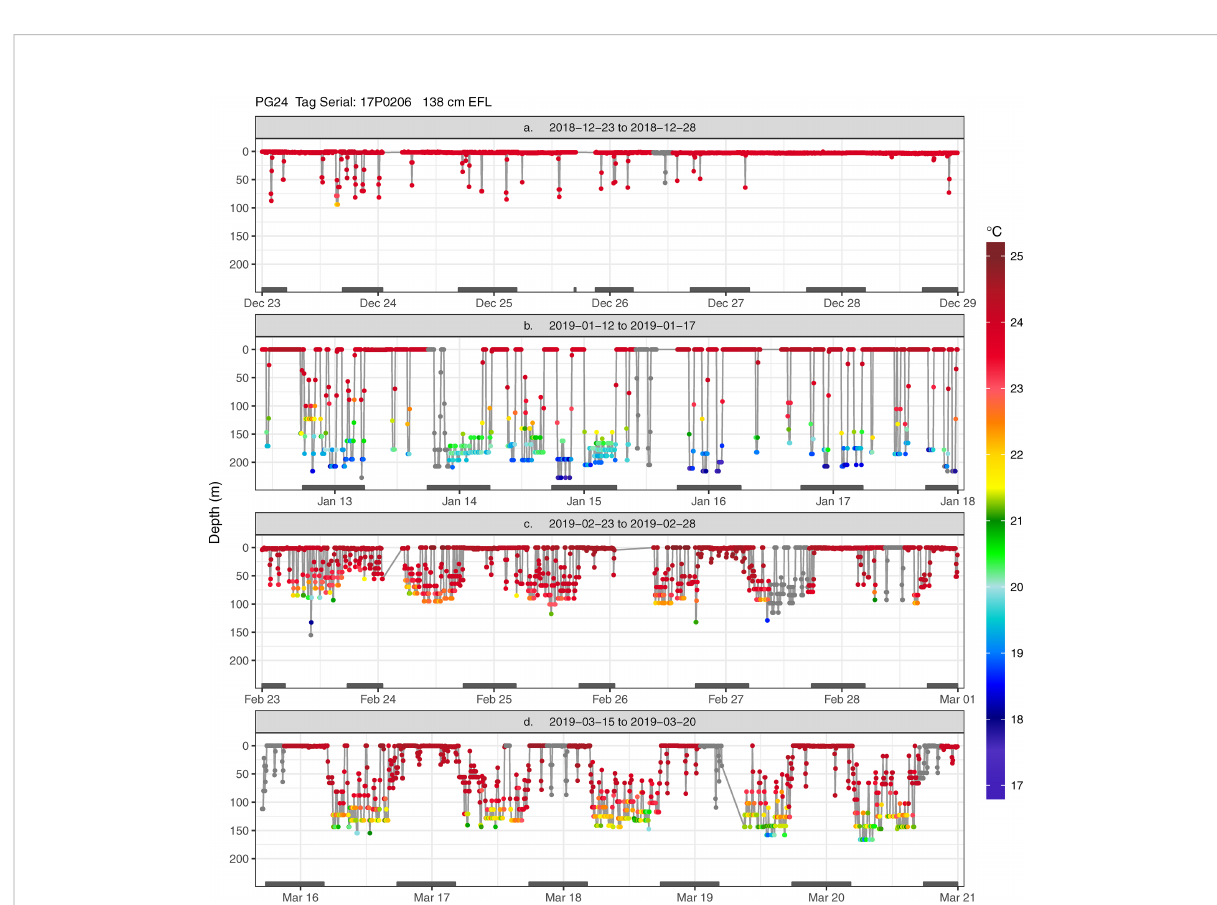
FIGURE 4 Transmitted depth and temperature time series of striped marlin PG24 from (A) 2018-12-23 to 2018-12-28, (B) 2019-01-12 to 2019-01-17, (C) 2019-02-23 to 2019-02-28, and (D) 2019-03-15 to 2019-03-20. When temperature values were not received through the Argos satellites, corresponding depth values are shown in grey. Grey bars on the x-axis (date scale) denote